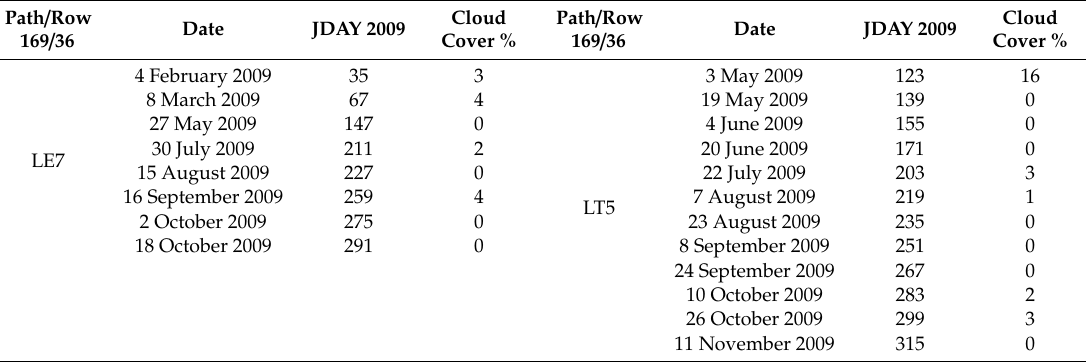
Table 2. Landsat images used to estimate T w in the Tigris River at Baeji.